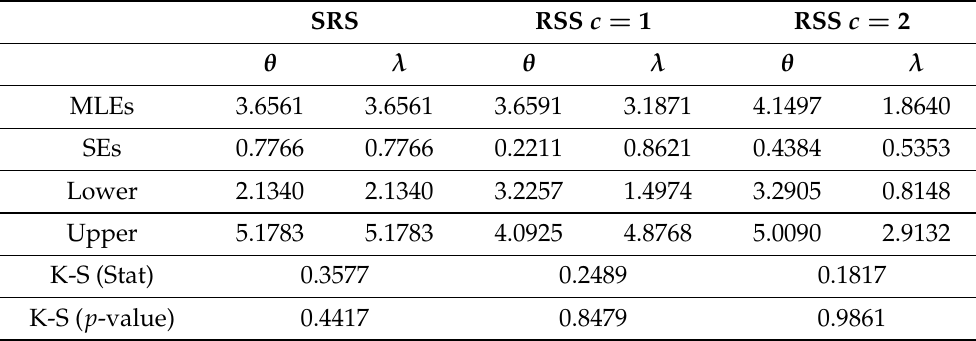
Table 11. MLEs of the parameters θ and λ of the GB( θ , λ ) distribution with lower and upper bounds of CI, SEs, Kolmogorov-Smirnov (K-S) (stat), and (K-S) p -value under the SRS and RSS schemes when n = 5.